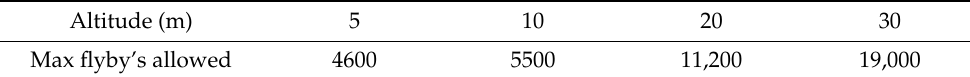
Table 7. Maximum allowable fly overs for an L DEN of 53 dB (A).